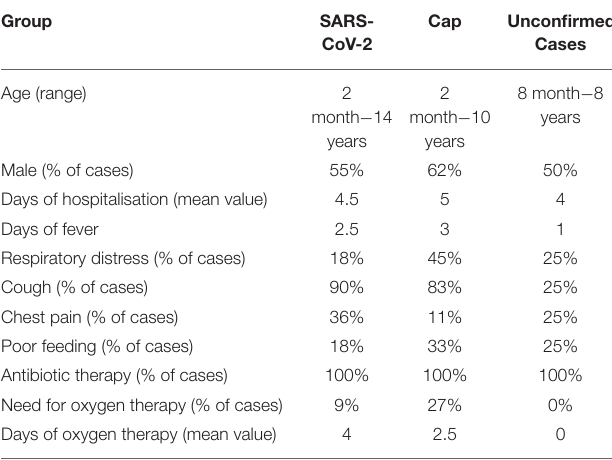
TABLE 1 | General and clinical characteristics of population. Group SARS-